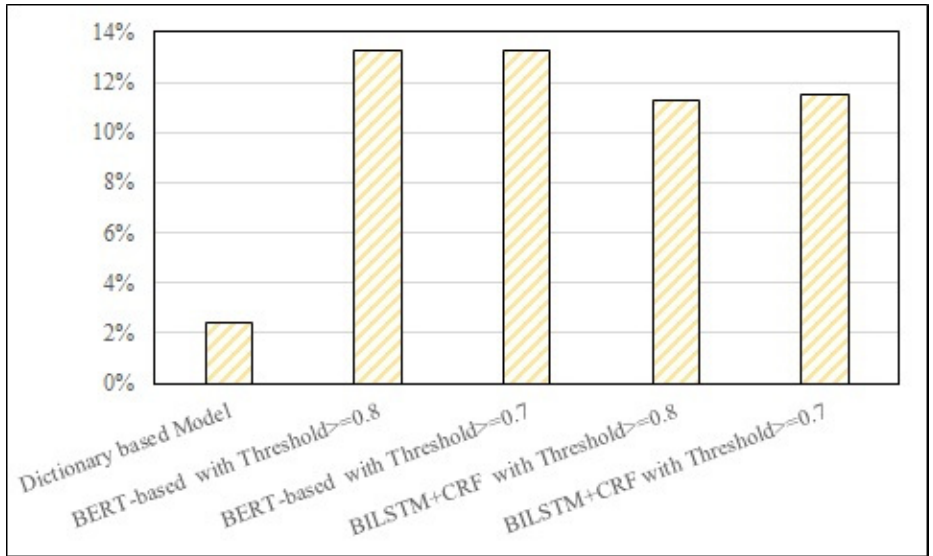
Figure 13. Chart showing the impact of the different entity-linked models on the percentage of scraped symptoms interlinked with symptoms ontology.